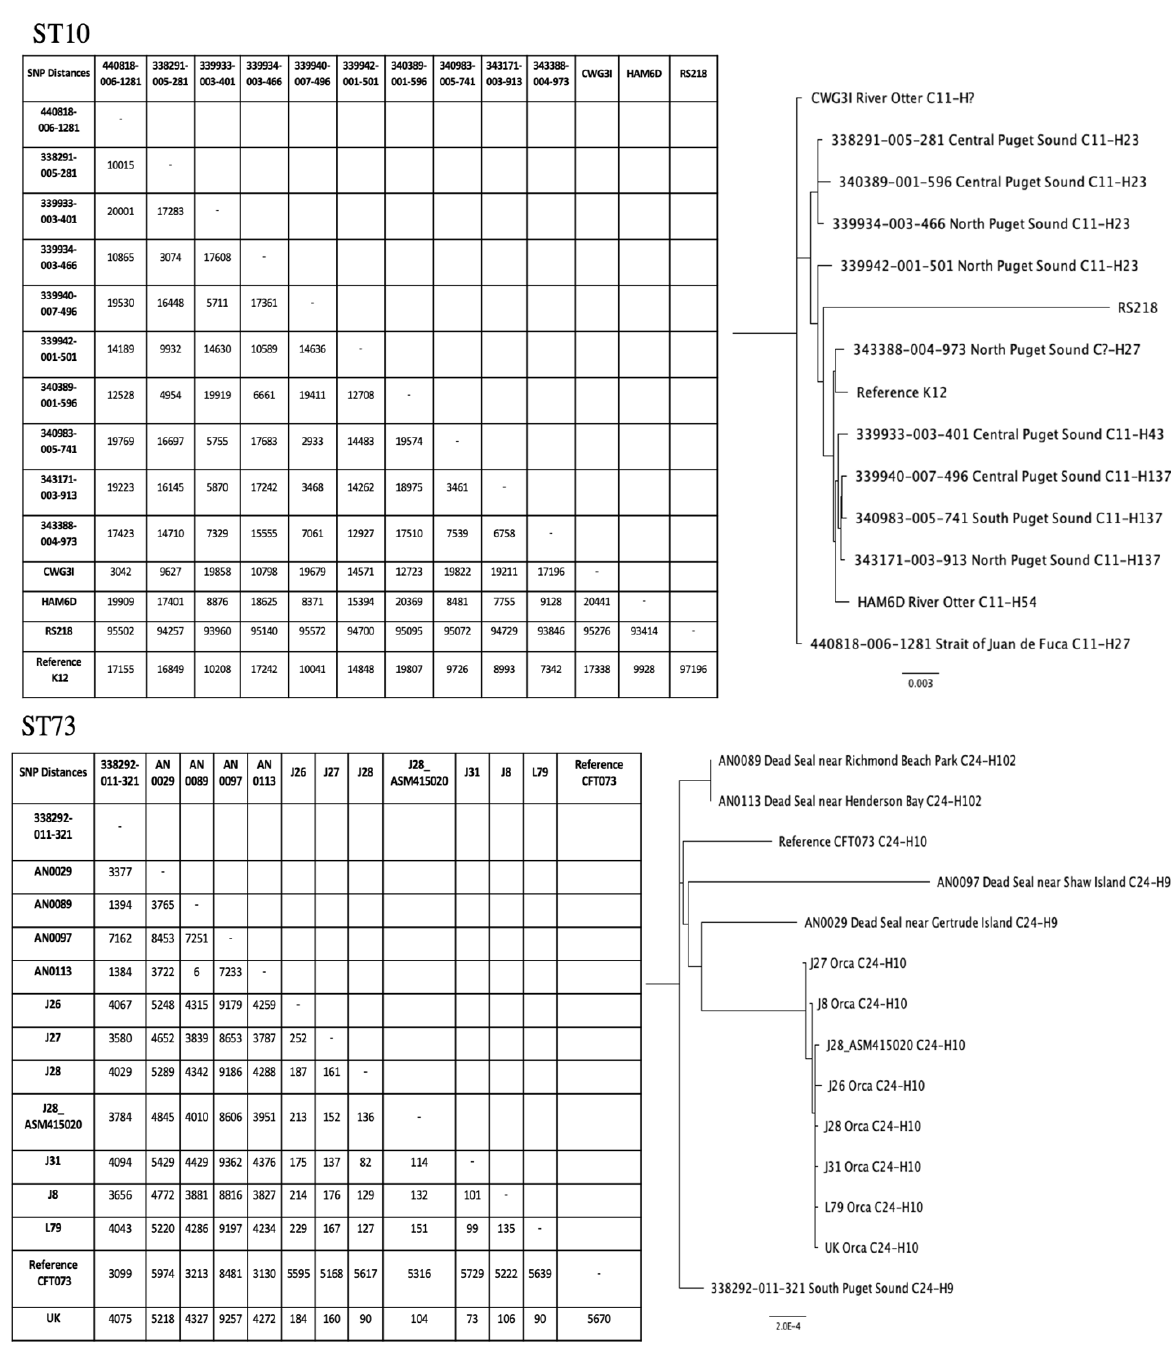
Figure 2. ST10 and ST73 SNP matrices and phylogenetic trees.